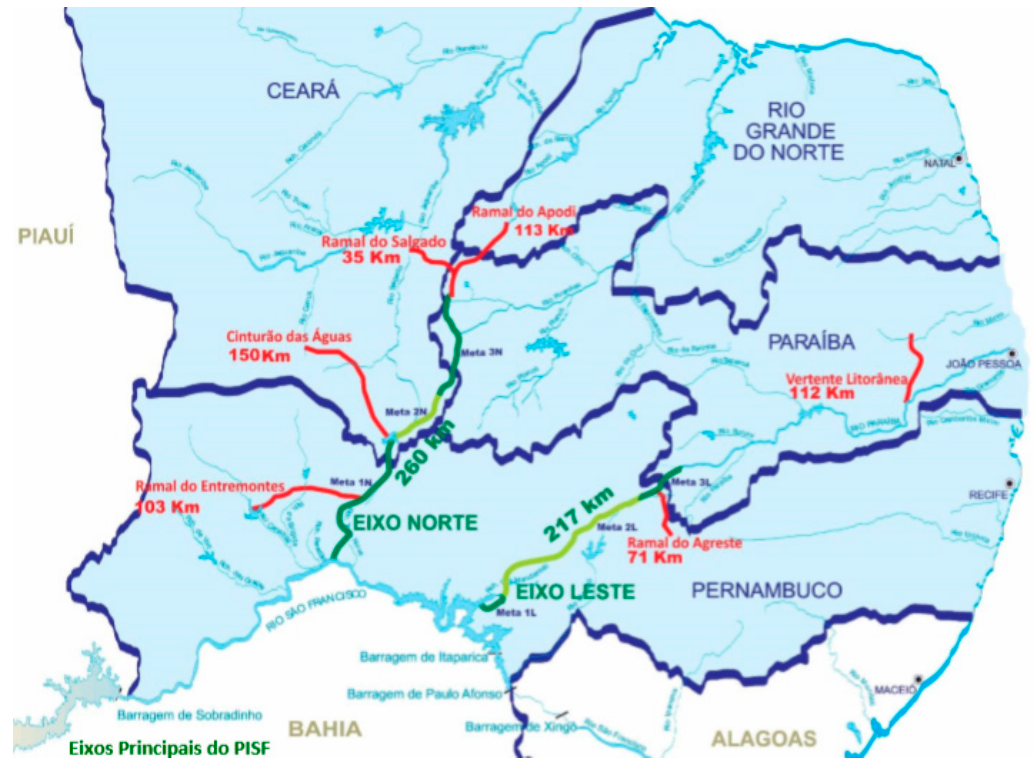
Figure 4. Location of the São Francisco River Basin Integration Project [43].